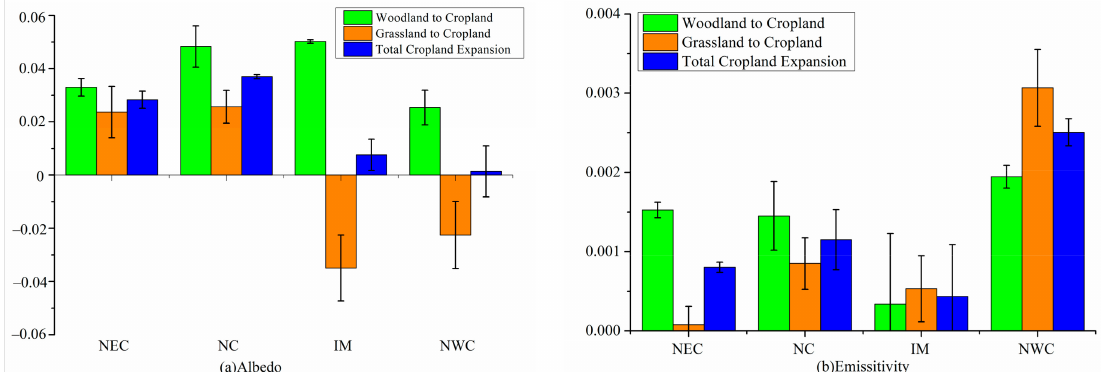
Figure 6. Change of albedo ( a ) and emissivity ( b ) due to cropland expansion in different